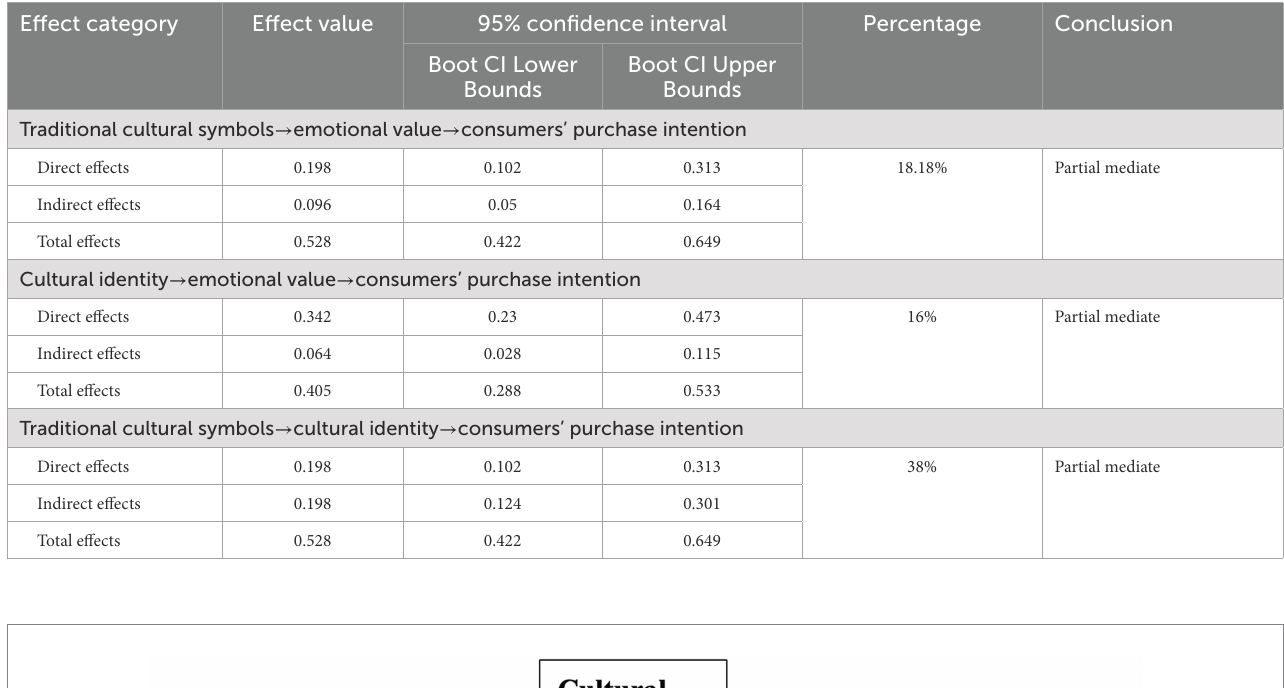
TABLE 7 Test of the potential mediating